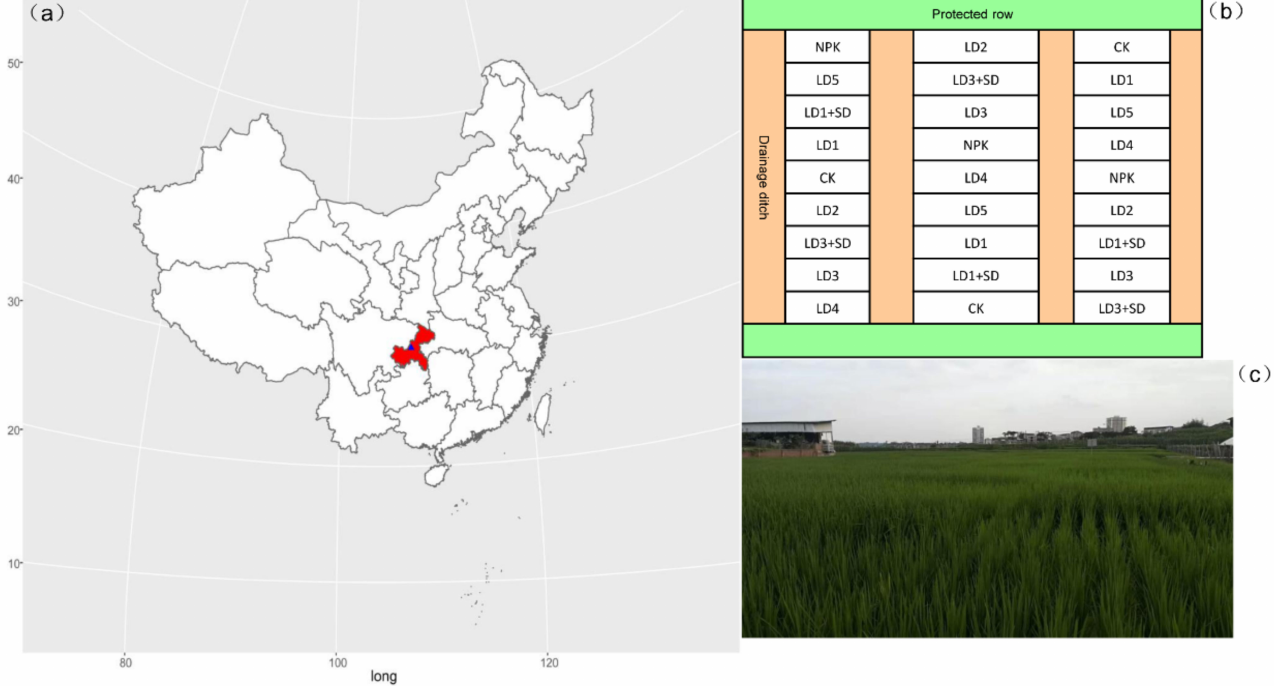
Figure 1. The site ( a ), plot distribution ( b ), and picture ( c ) for the field experiment, respectively. CK, NPK, LD1, LD2, LD3, LD4, LD5, LD1 + SD, and LD3 + SD represent control, chemical fertilizer, liquid digestate (LD1, 150 t ha − 1 ; LD2, 225 t ha − 1 ; LD3, 300 t ha − 1 ; LD4, 375 t ha − 1 ; LD5, 450 t ha − 1 ), and liquid digestate combined with solid digestate,